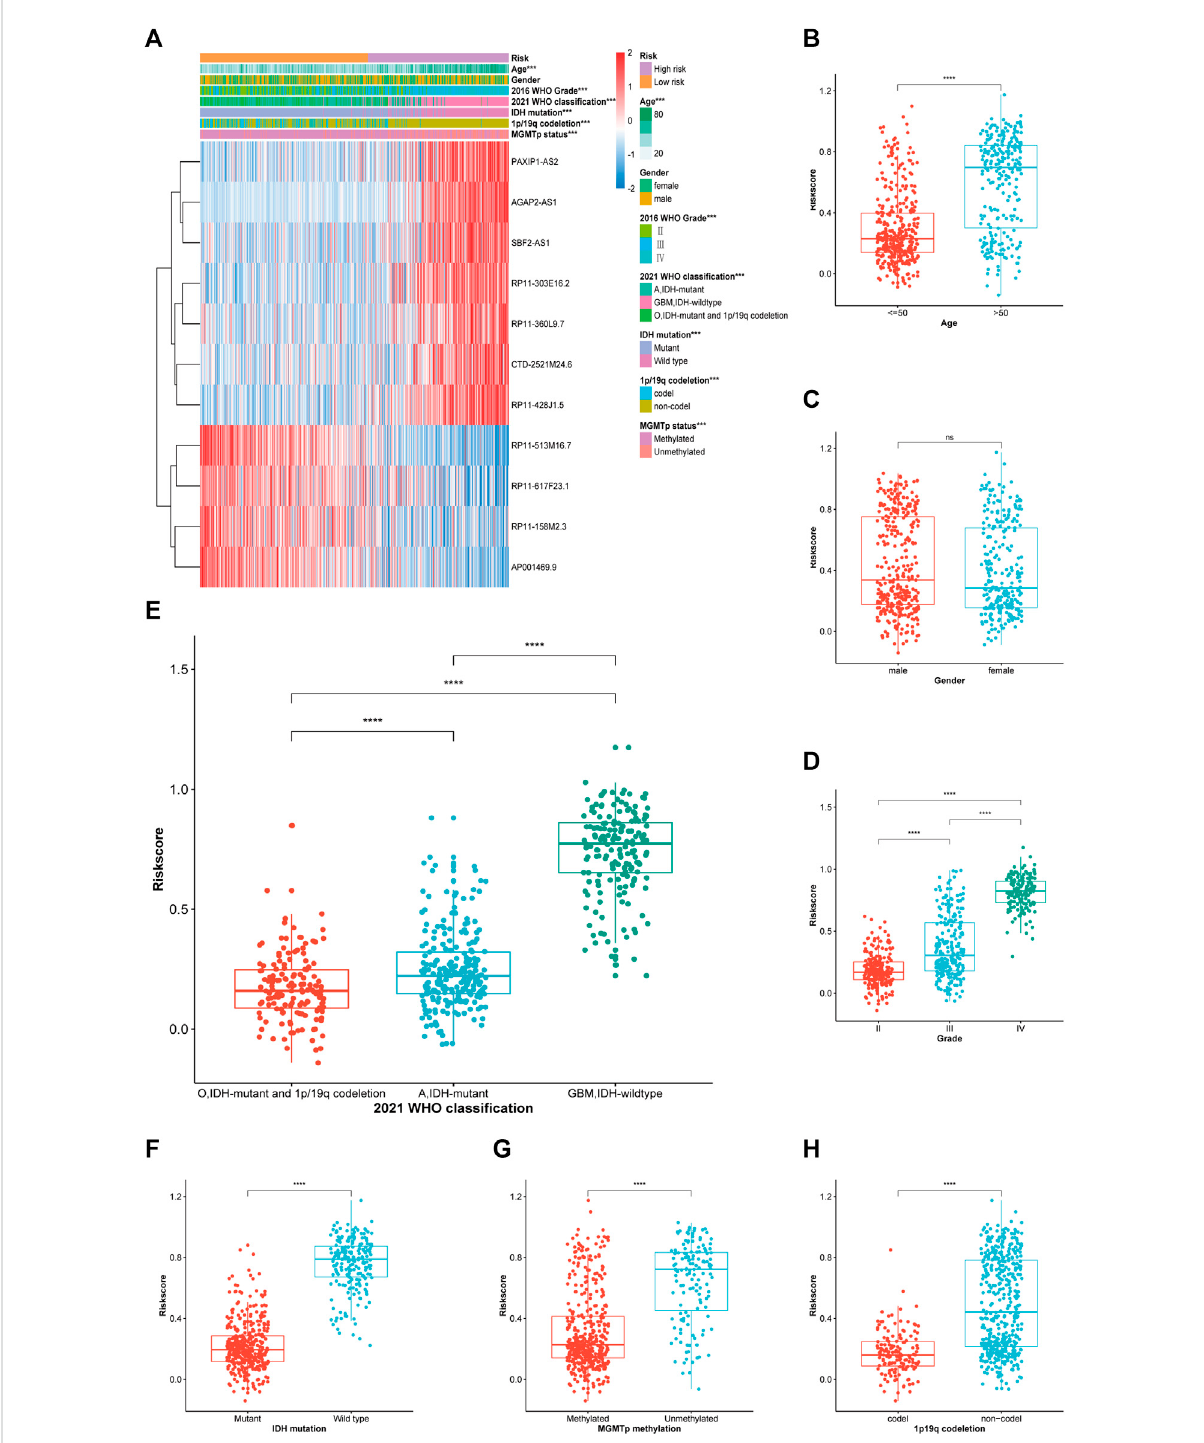
FIGURE 4 Correlation analysis between the PRL classi fi er and clinical-pathological parameters in TCGA cohort. (A) A heatmap illustrating the distribution oftheclinical-pathologicalfeaturesandexpressionpro fi lesofthe11chosenPRLsinthehigh-andlow-riskgroups. (B – H) Variouslevelsofriskscores in patients who had gliomas classi fi ed by: sex, age, WHO grade, 2021 WHO classi fi cation, IDH mutation status, 1p/19q codeletion, and MGMT promoter methylation. A, astrocytoma; O, oligodendroglioma; GBM, * p < 0.05, ** p < 0.01, and *** p < 0.001. ns, no signi fi